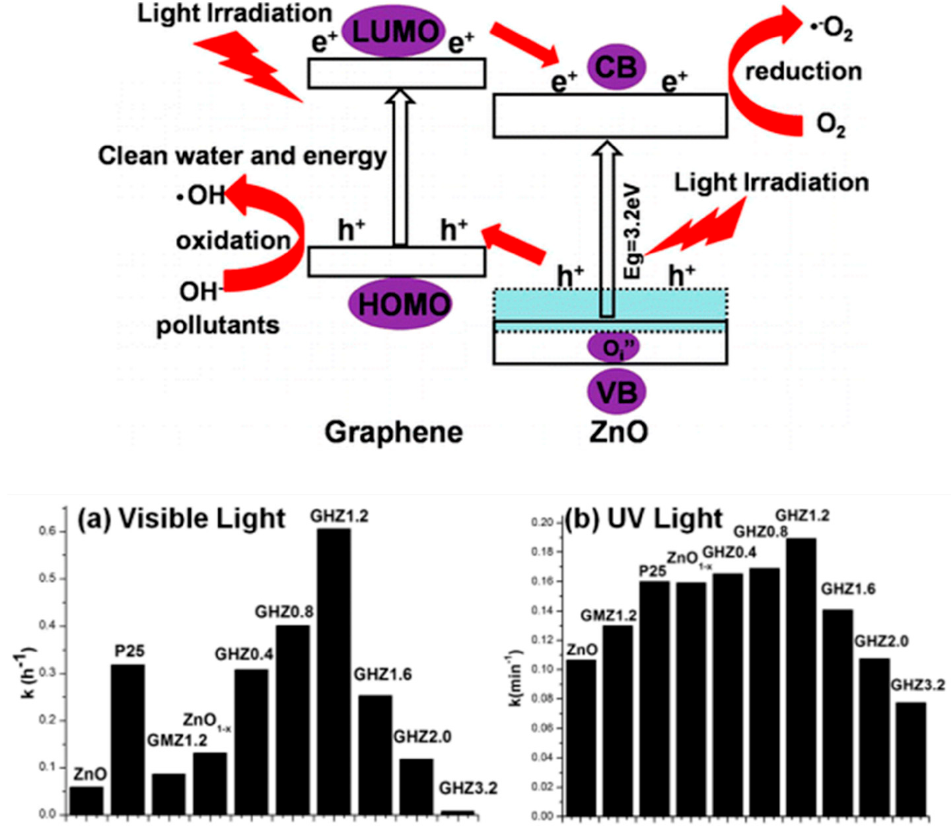
Figure 7. Schematic demonstrating the photocatalytic process over ZnO 1 − x /graphene. Photocatalytic degradation of MB over ZnO 1 − x and ZnO 1 − x /graphene under illumination of ( a ) visible light and ( b ) UV light. Adapted with permission from [206]. Copyright 2013, American Chemical Society.